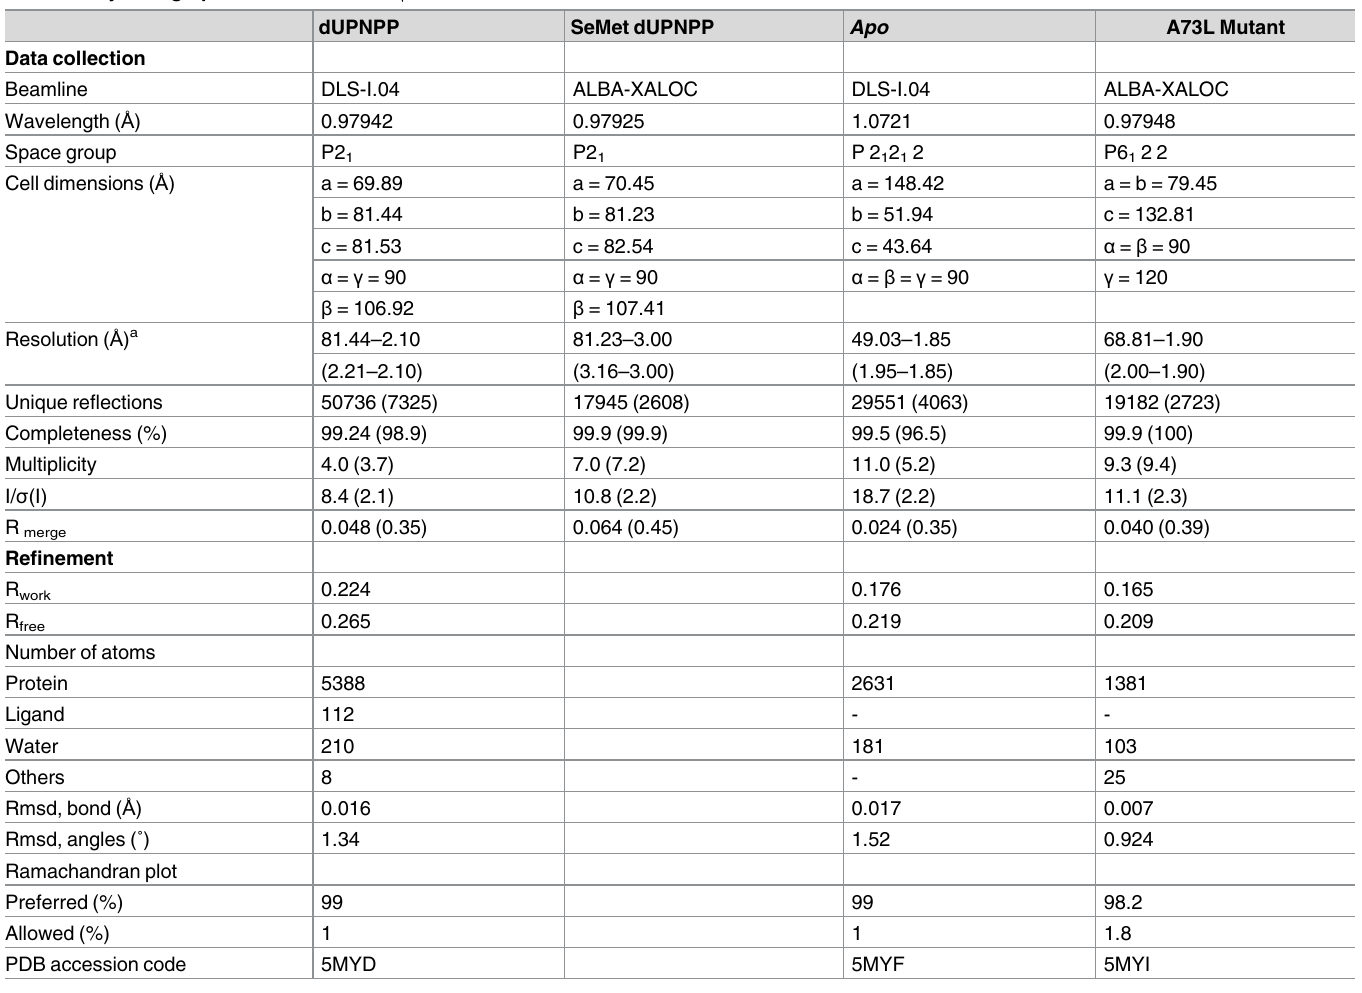
Table 3. Crystallographic statistics of Dut ϕ DI